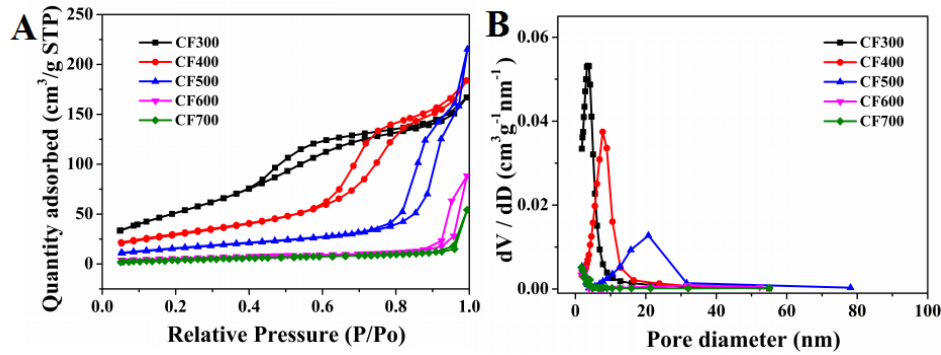
Figure 5. ( A ) N 2 adsorption/desorption isotherms and ( B ) pore size distribution of the porous CoFe 2 O 4 .